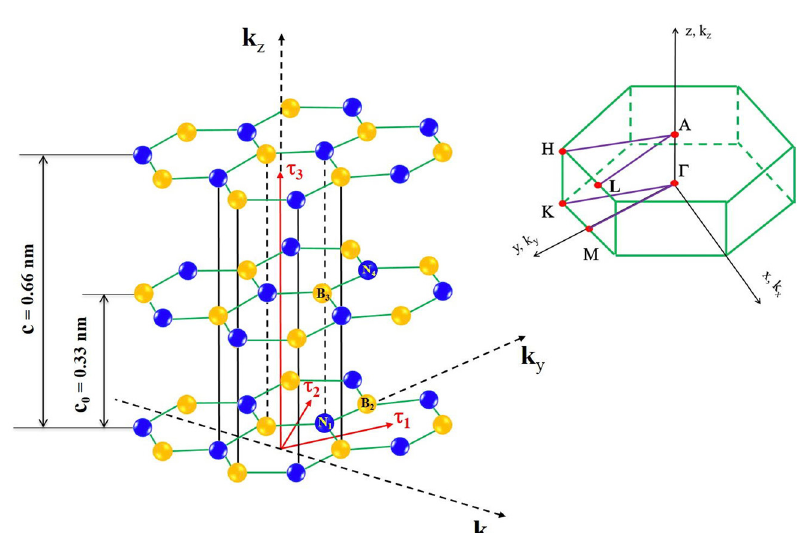
Figure 4: BN monolayer (a), bi-layer AA ′ stacking (b) and three layer AA ′ stacking. Boron atoms are plot as orange spheres and nitrogenatomsaregreyedones.Thecaxisis vertical.